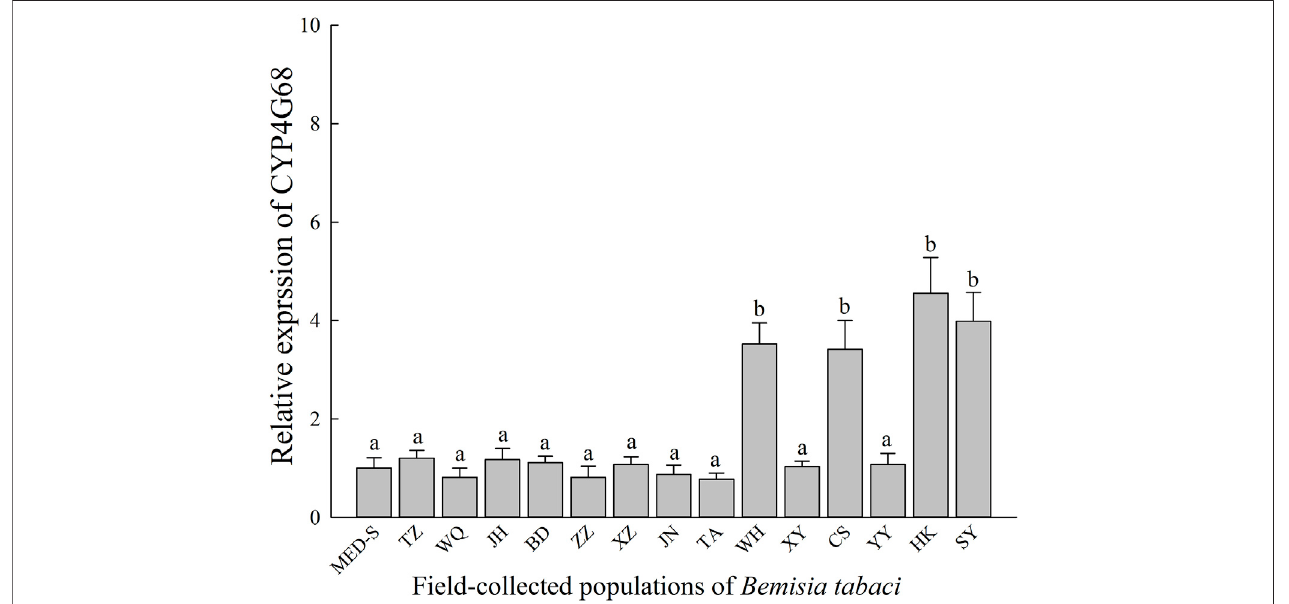
FIGURE 3 | Expression pro fi les of CYP4G68 in 14 fi eld-evolved cyantraniliprole-resistant B. tabaci populations from China.